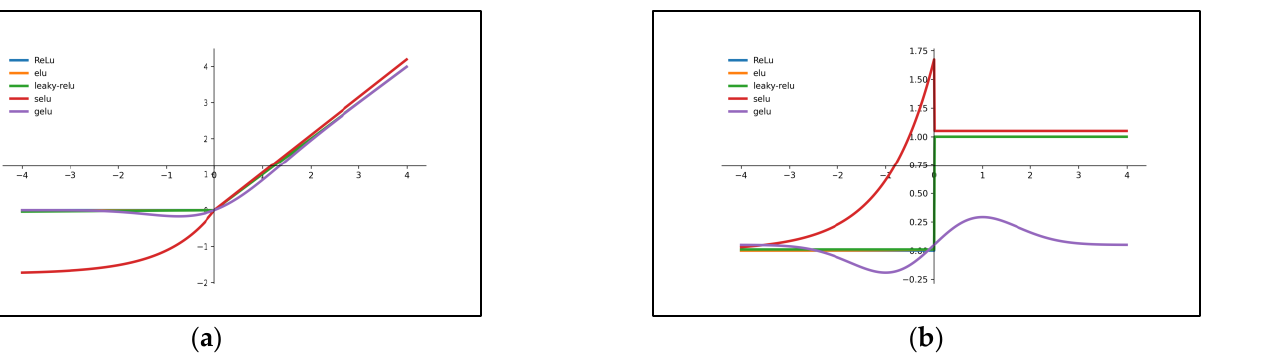
Figure 14. Images of different activation functions ( a ) and their derivatives ( b ). Table 2. Different activation function formulas and the effects.